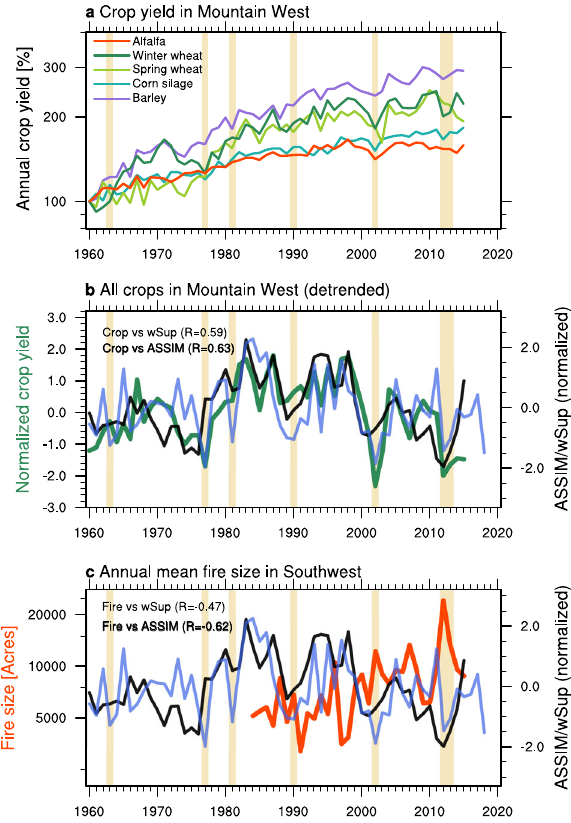
Fig. 6 Interannual-to-decadal variability of agriculture production and mean large wild fi re size. Annual mean time series of a crop yields in the Mountain West (Colorado, Nevada, Utah, Wyoming, and Idaho), b average of normalized and detrended crop yields in the Mountain West (green; see Supplementary Methods), and c mean large- fi re size in Colorado, Nevada, Utah, Wyoming, Idaho, Oregon, California, Arizona, and New Mexico. The observed Colorado River water supply and its reconstruction in the assimilation run in Fig. 1a are replotted in b , c as well (blue and black lines). Years with prominent water supply shortages are highlighted by yellow shading (1963, 1977, 1981, 1990, 2002, 2012, and 2013). Annual crop yields are represented by a percentage relative to the values in 1960. The crop yield in b was linearly detrended in each state, each crop, averaged across fi ve states, normalized by one standard deviation, and then we took the ensemble mean of all fi ve crops (see Supplementary Fig. 3). Annual mean fi re size is calculated by fi re burned area divided by the number of large fi re events per